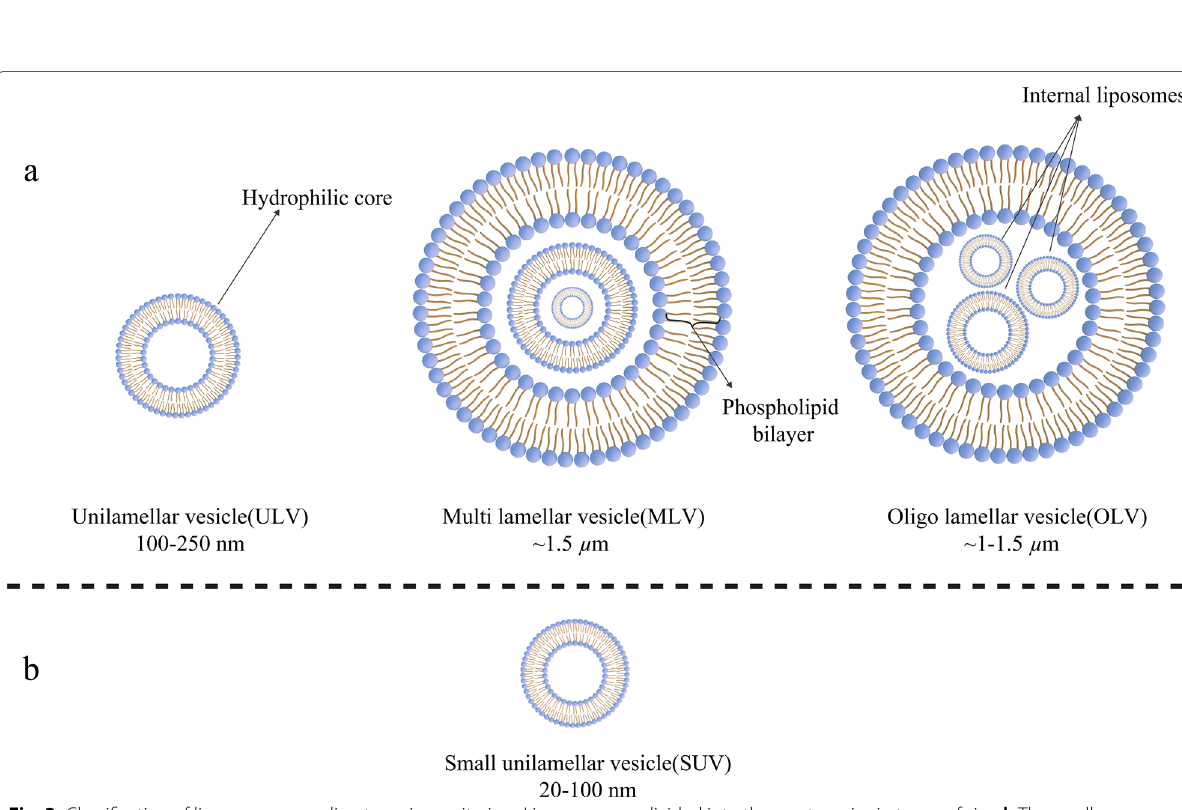
Fig. 3 Classification of liposomes according to various criteria: a Liposomes are divided into three categories in terms of size; b The small unilamellar vesicle (SUV) structure, as a member of unilamellar vesicles (ULVs), which has a noticeable small